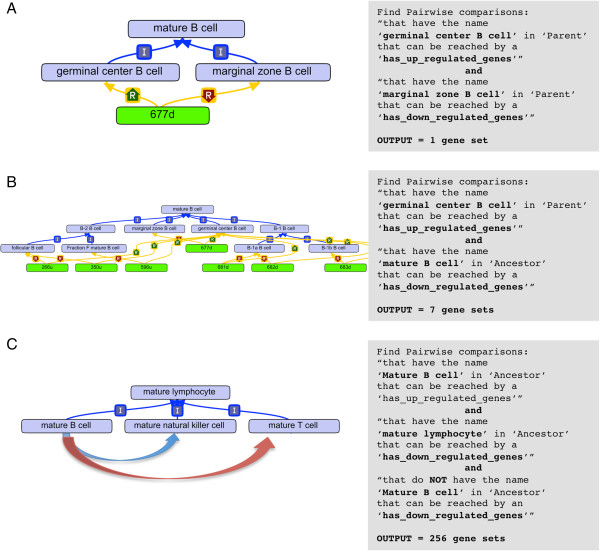
Searching for pairwise comparisons mapped to the Cell Ontology. A) Gene lists resulting from almost 8000 pairwise comparisons were mapped to the CL by creating terms (in green) that represent genes with 1.5 fold-higher or 1.5-fold-lower expression, between two cell types. These terms were mapped by creating has_genes_up_regulated_for (green R relation) and has_genes_down_regulated_for (red R relation) relationships. This structure allows for ontologically driven searches, depicted in text. B) Pairwise comparisons for genes up regulated in ‘germinal center B cell’ compared to all other mature B cells. Note how search finds the other B cell types by ‘Ancestor’ of ‘mature B cell’. C) Search strategy to find the 256 pairwise comparisons that exist between mature B cells and other types of mature lymphocytes. Note the third constraint that is added in the search to eliminate comparisons between types of mature B cells.